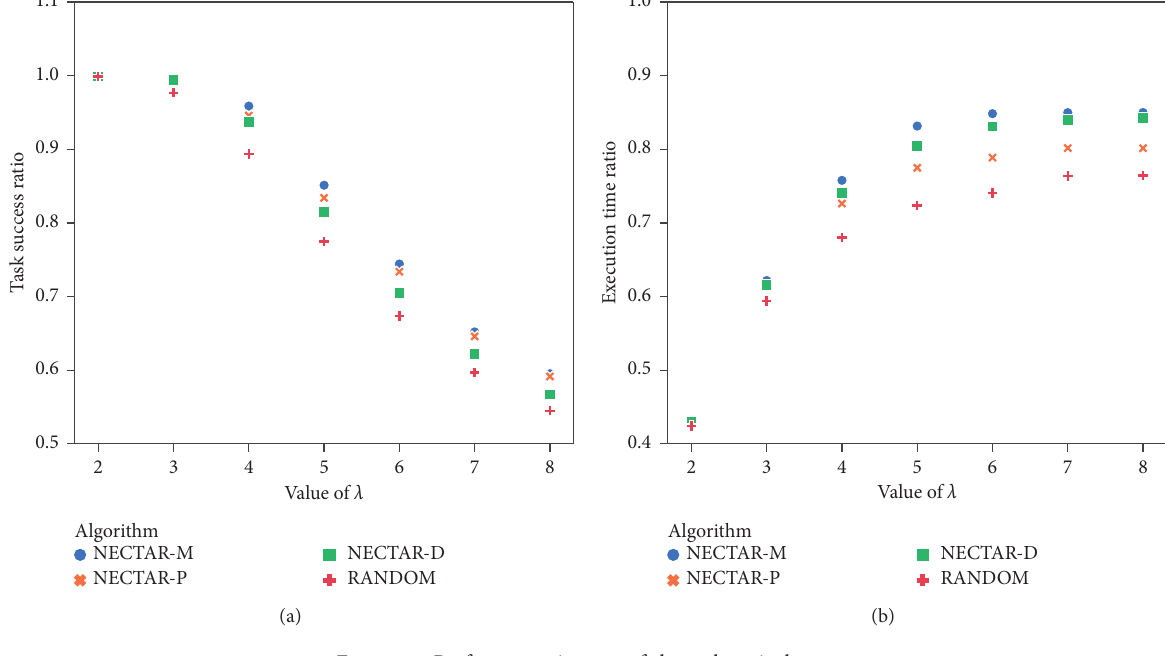
Figure 5: Performance impact of the task arrival rate.